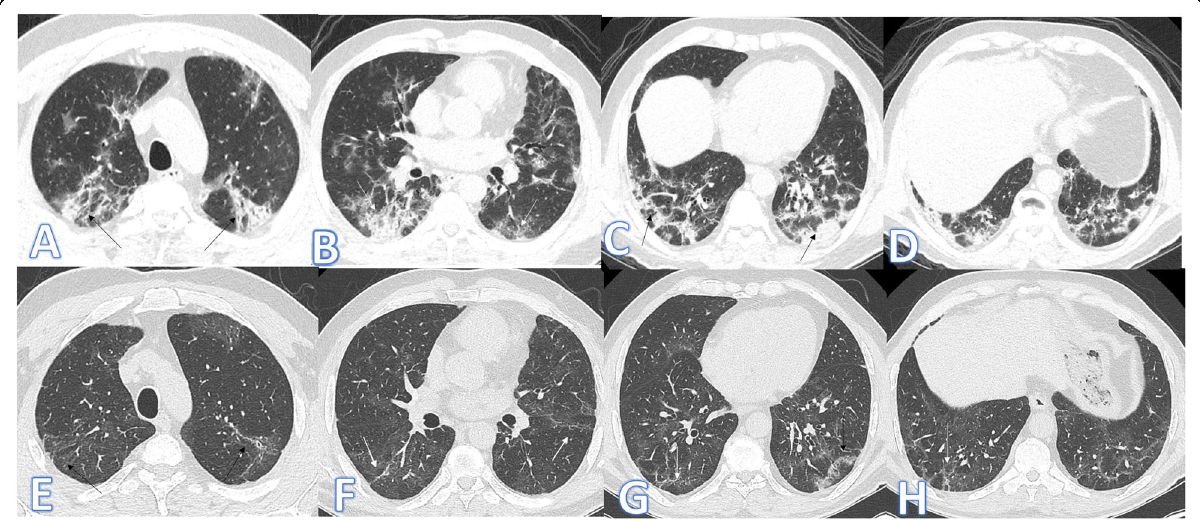
Fig. 2 Fifty-nine-year-old male: he has DM; peak CT severity score 10; consolidation/crazy-paving score 8. No ICU admission; laboratory results show lymphopenia, high CRP, D -dimer, and serum ferritin. Steroid was given; length of stay during hospitalization is 10 days. Peak CT ( a – d ) shows bilateral peripheral consolidation patches mainly in the lower lobes (arrows). Follow-up CT 2 months after discharge ( e – h ) shows residual fibrosis with parenchymal bands, coarse reticular pattern (arrows), and atoll sign (black arrow in g